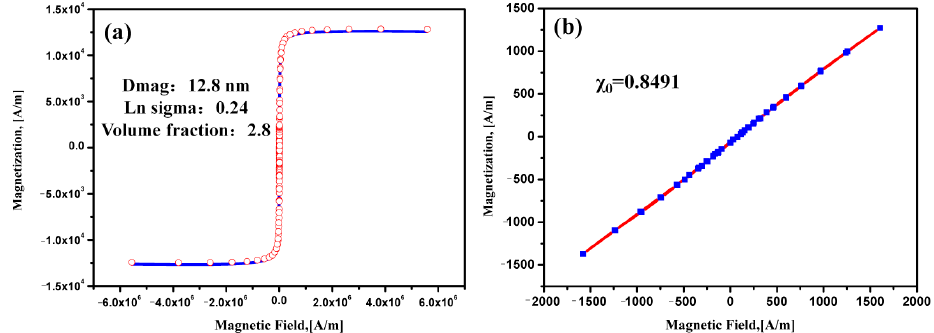
Figure 5. The magnetic hysteresis curves of the amorphous MF ( a ) and magnetization curve at low fields of the amorphous-based MF ( b ).